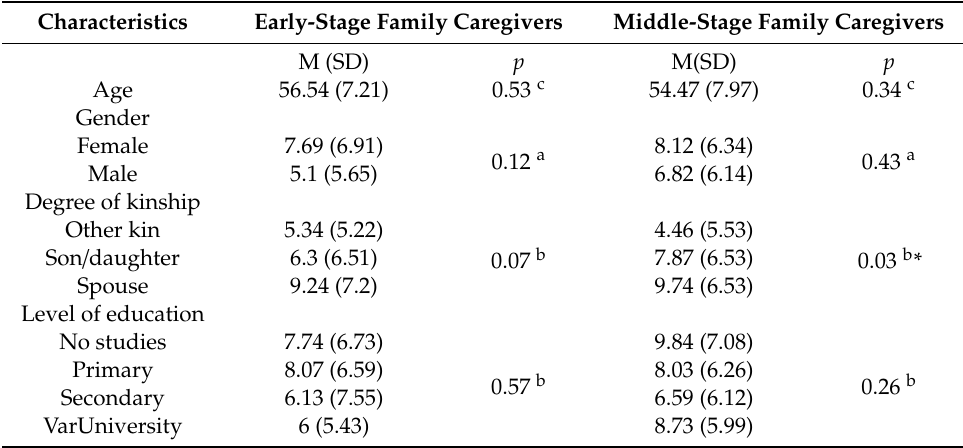
Table 2. Family caregivers’ sociodemographic characteristics and perceived health, depending on the stage of the